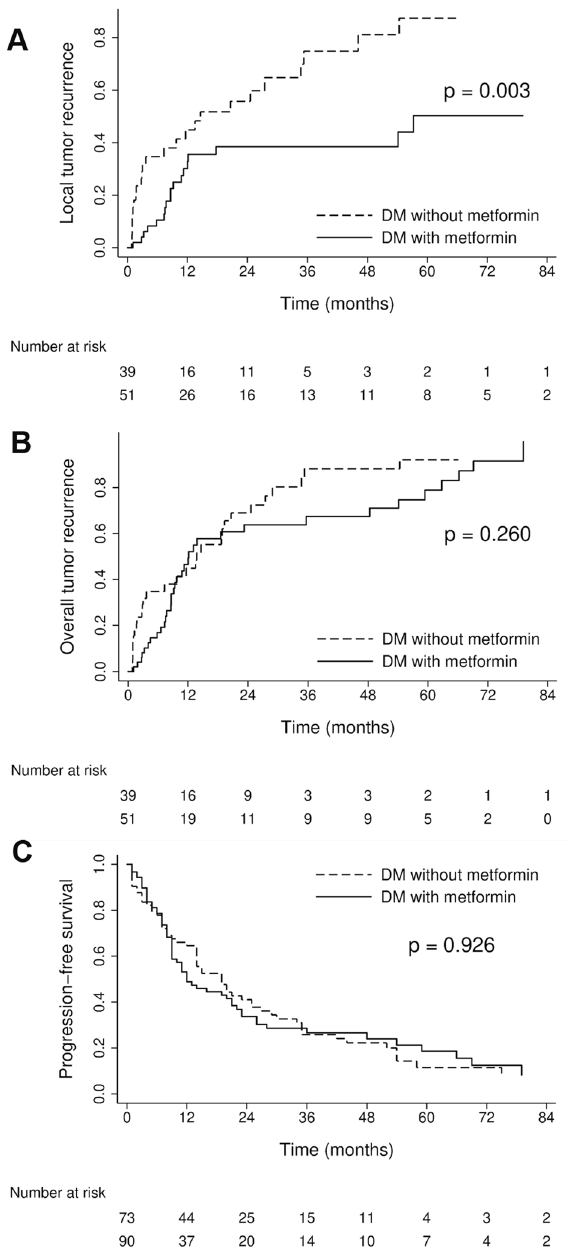
Figure 2. Kaplan–Meier plots for local tumor recurrence-free survival, overall recurrence-free survival and progression free survival after TACE according to metformin therapy. Local and overall recurrent-free survivals were analyzed in patients with complete response after initial TACE ( A and B ; n = 90), and the progression-free survival was calculated in overall patients ( C ; n = 163). The metformin group showed a significantly reduced local recurrence rate than the control group ( A ), but the overall recurrence was not different between the two groups ( B ). Progression-free survival was not different between control and metformin group, either ( C ). DM without metformin, patients with T2DM not treated with metformin; DM with metformin, patients with T2DM treated with metformin. HCC hepatocellular carcinoma, DM diabetes